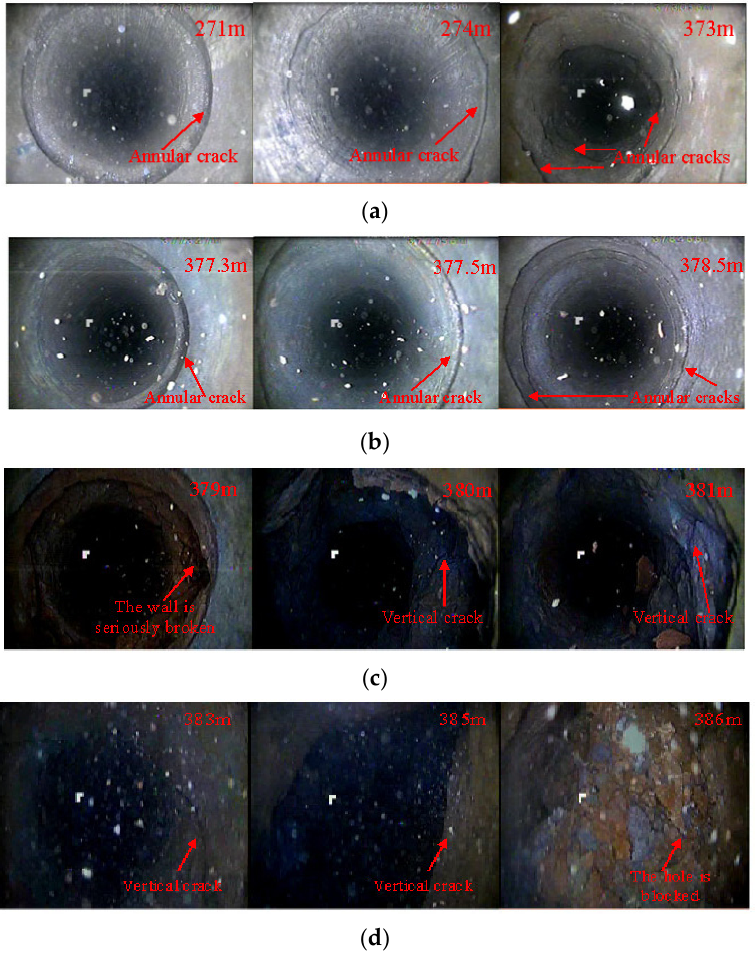
Figure 13. The diagram in Y4 borehole. ( a ) The damage from 271 m to 373 m, ( b ) the damage from 377.3 m to 378.5 m, ( c ) the damage from 379 m to 381 m, ( d ) the damage from 383 m to 386